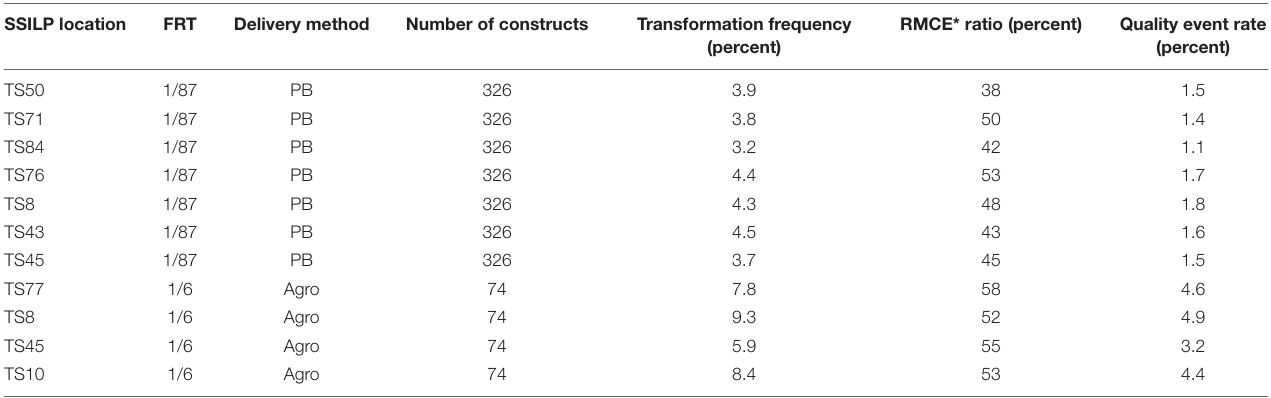
TABLE 3 | Integration of trait gene to SSILP at CTL1 in